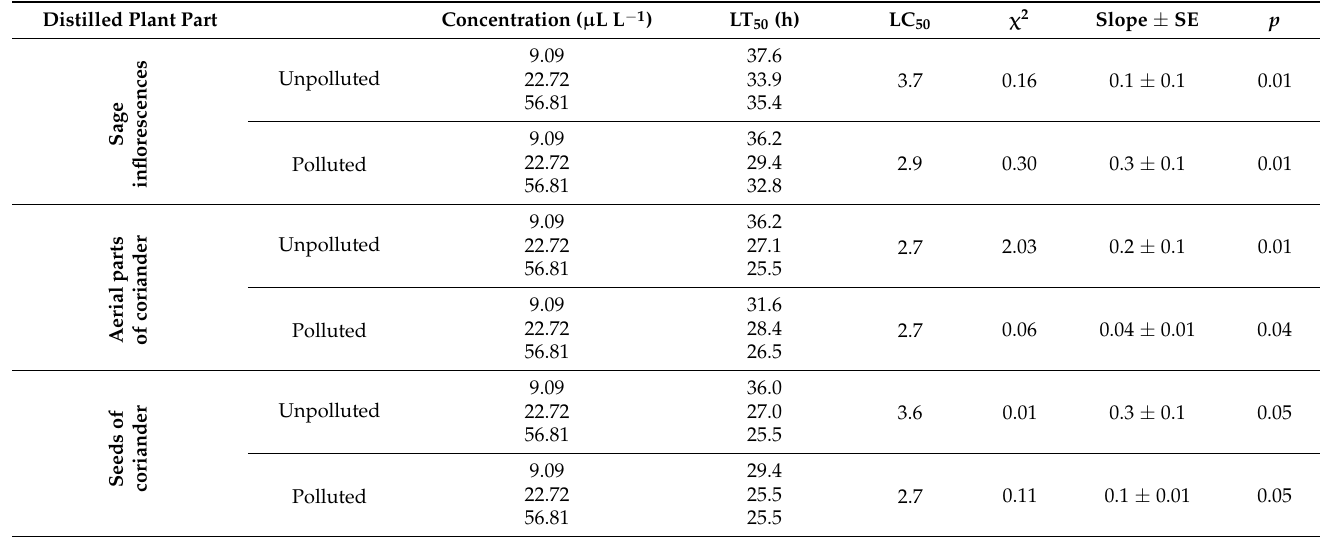
Table 6. LT 50 (h) and LC 50 ( µ L L − 1 ) values resulting from the fumigation bioassay against B. tabaci adults, for the three different tested EO, originating from the two experimental plots (n = 3).